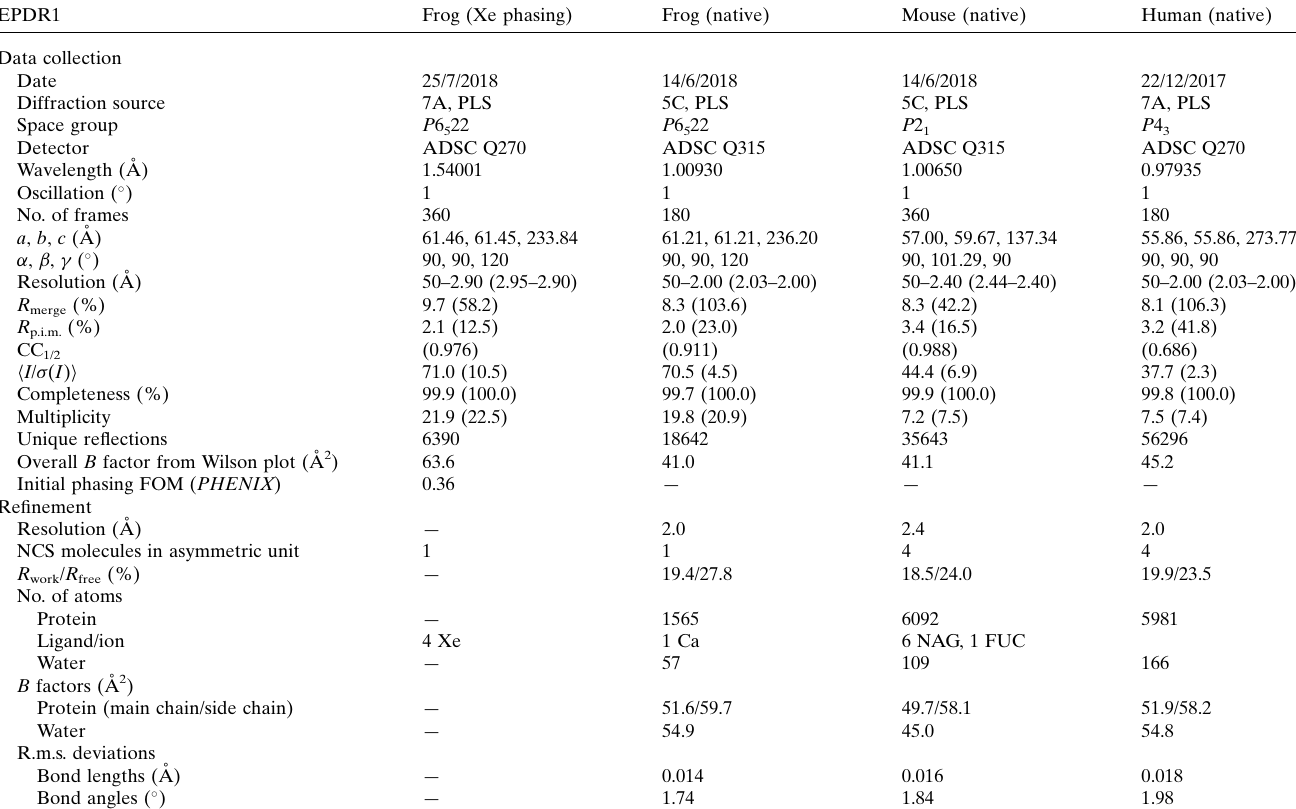
Table 1 Data-collection and refinement statistics for EPDR1. Values in parentheses are for the highest resolution shell.